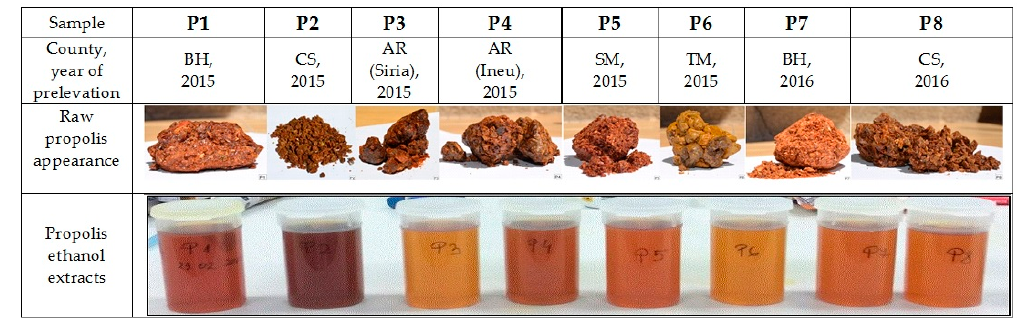
Figure 13. Collection sites and macroscopic appearance for propolis samples P1–P8. (BH—Bihor County, CS—Caras -Severin County, AR—Arad County, SM—Satu-Mare County, TM—Timi ș County).